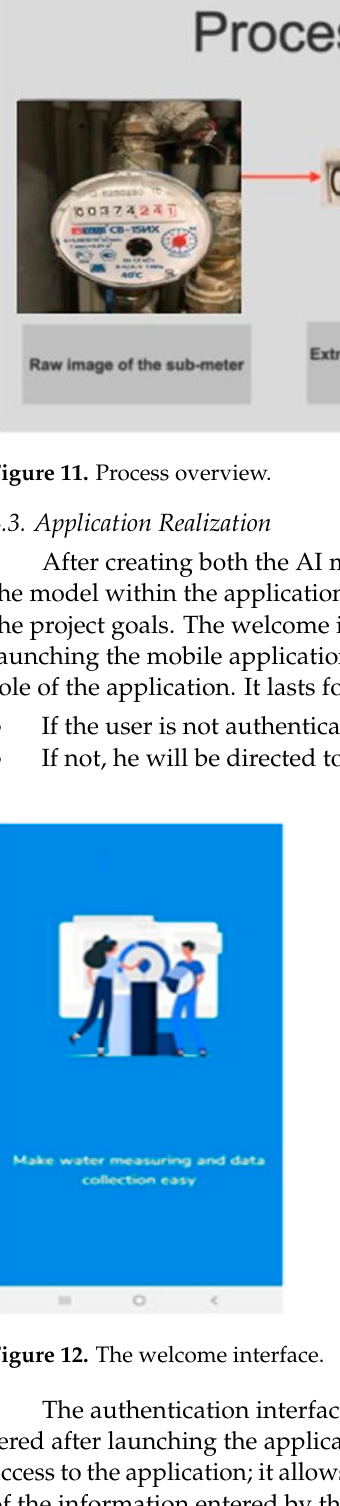
Figure 11. Process overview.